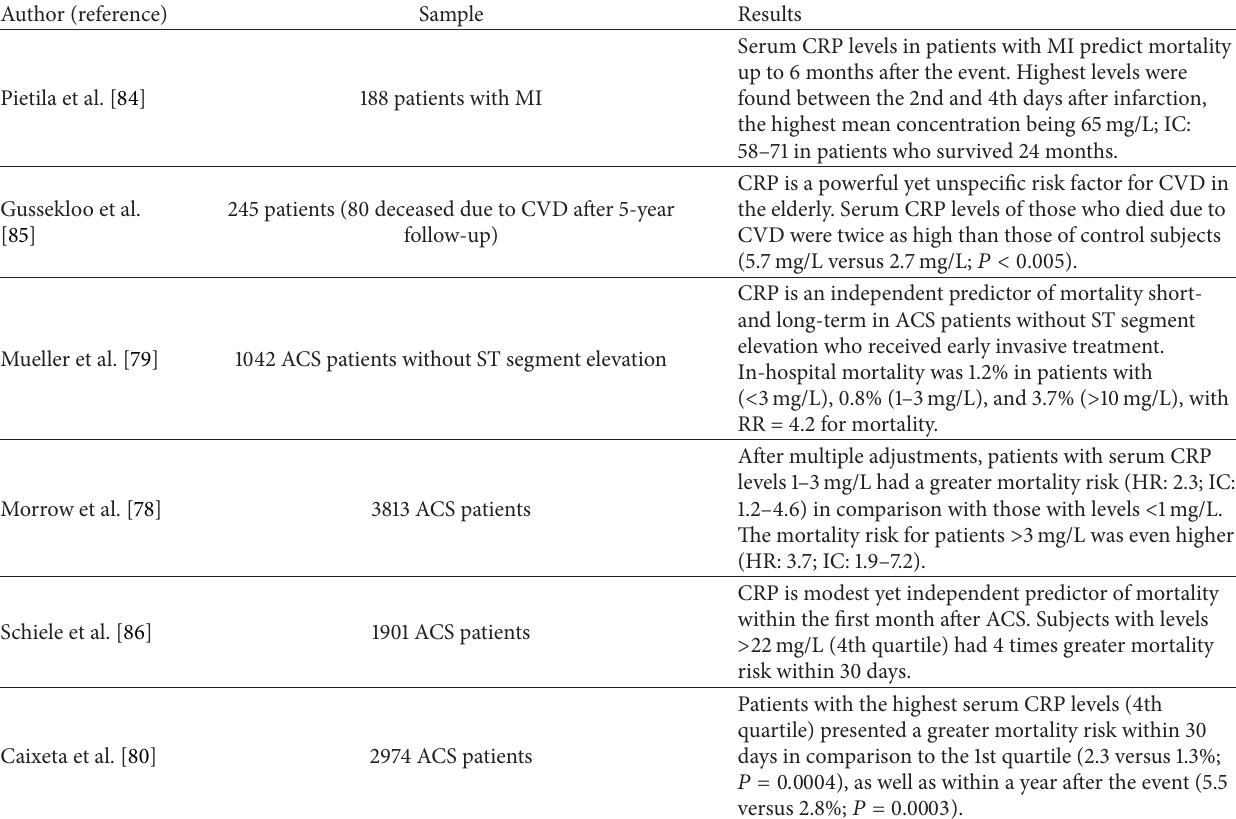
Table 4: Studies on acute coronary syndrome prognosis utilizing C-reactive